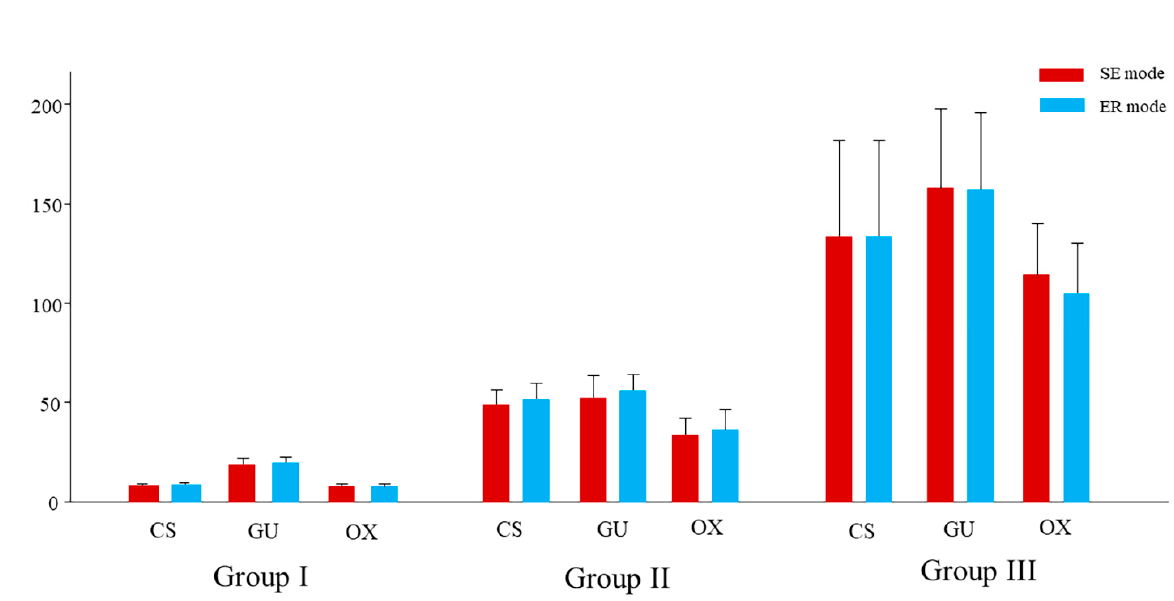
Figure 5. Thickness of adhesive layer in different application methods in different adhesive systems .